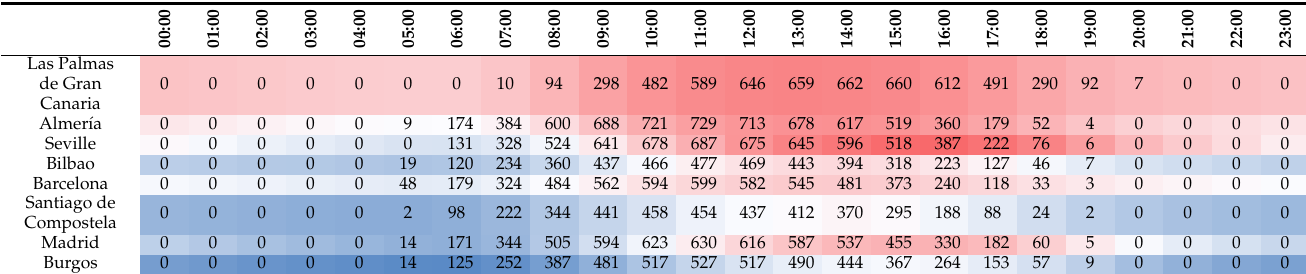
Table 6. Average annual hourly solar radiation (W/m 2 ) for each